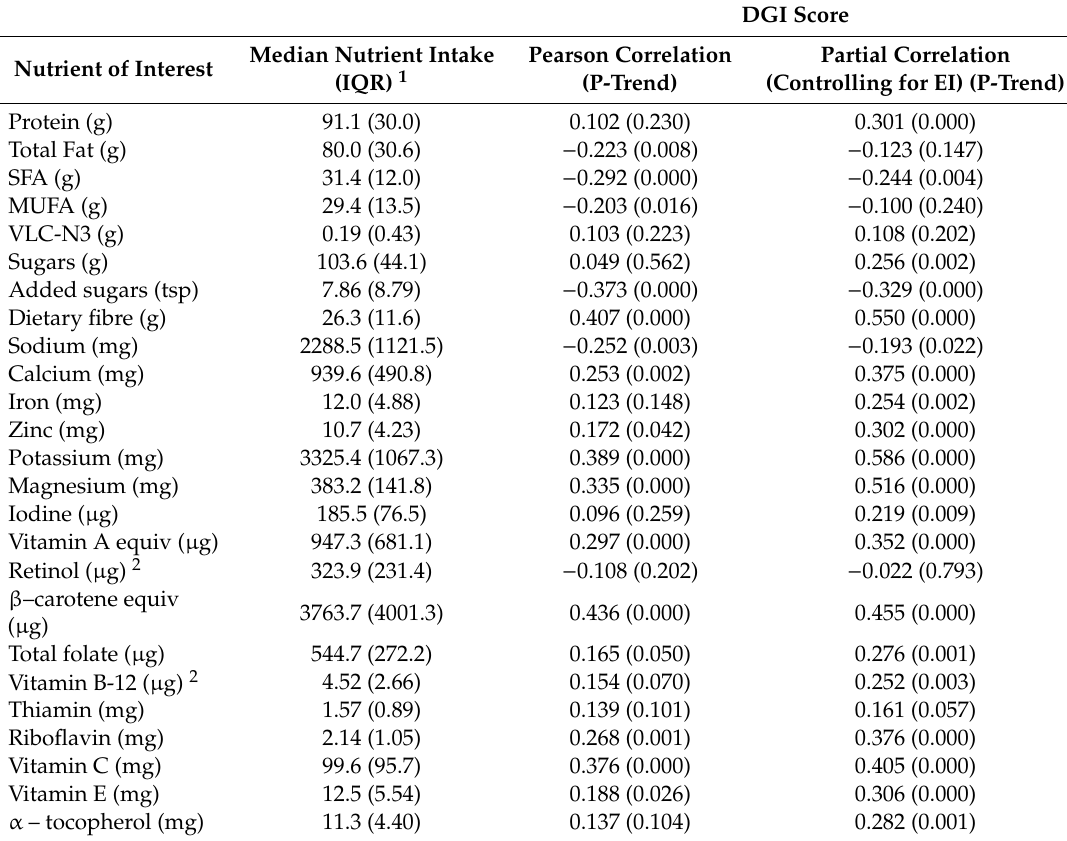
Table 4. Correlation coe ffi cients of log transformed Dietary Guideline Index score and nutrients among 141 middle-aged to older Australian adults who participated in a dietary intervention